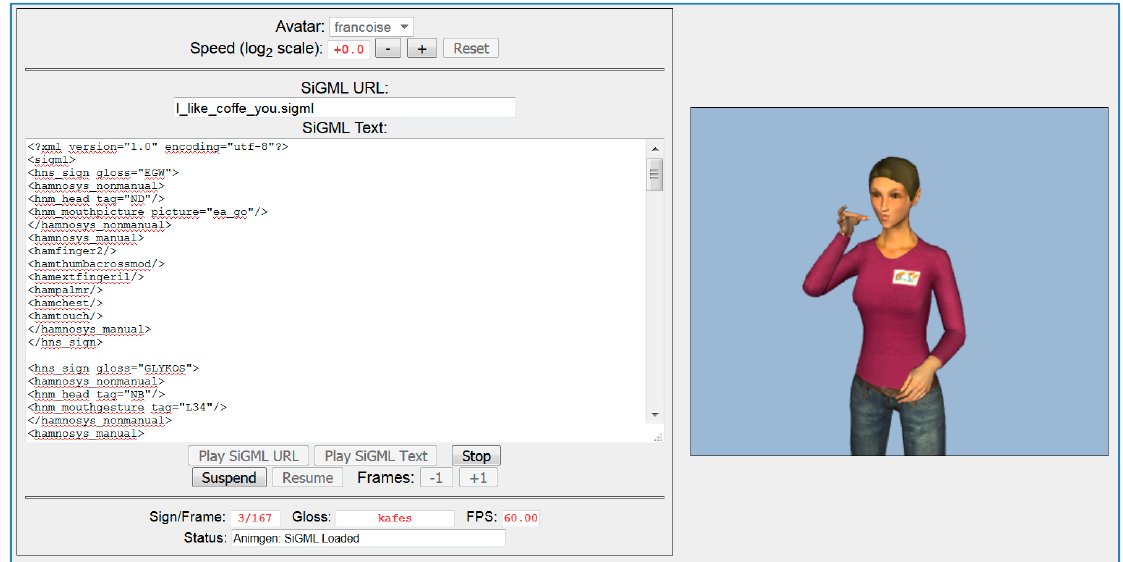
Figure 9. SiGML script and the corresponding visualization of the GSL sign “wild” in SiS-Builder.